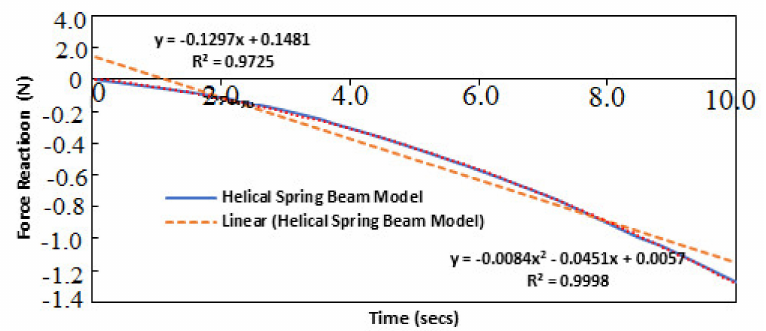
Figure 15. Helical spring beam model showing the force reaction of the marine bonded composite hose.